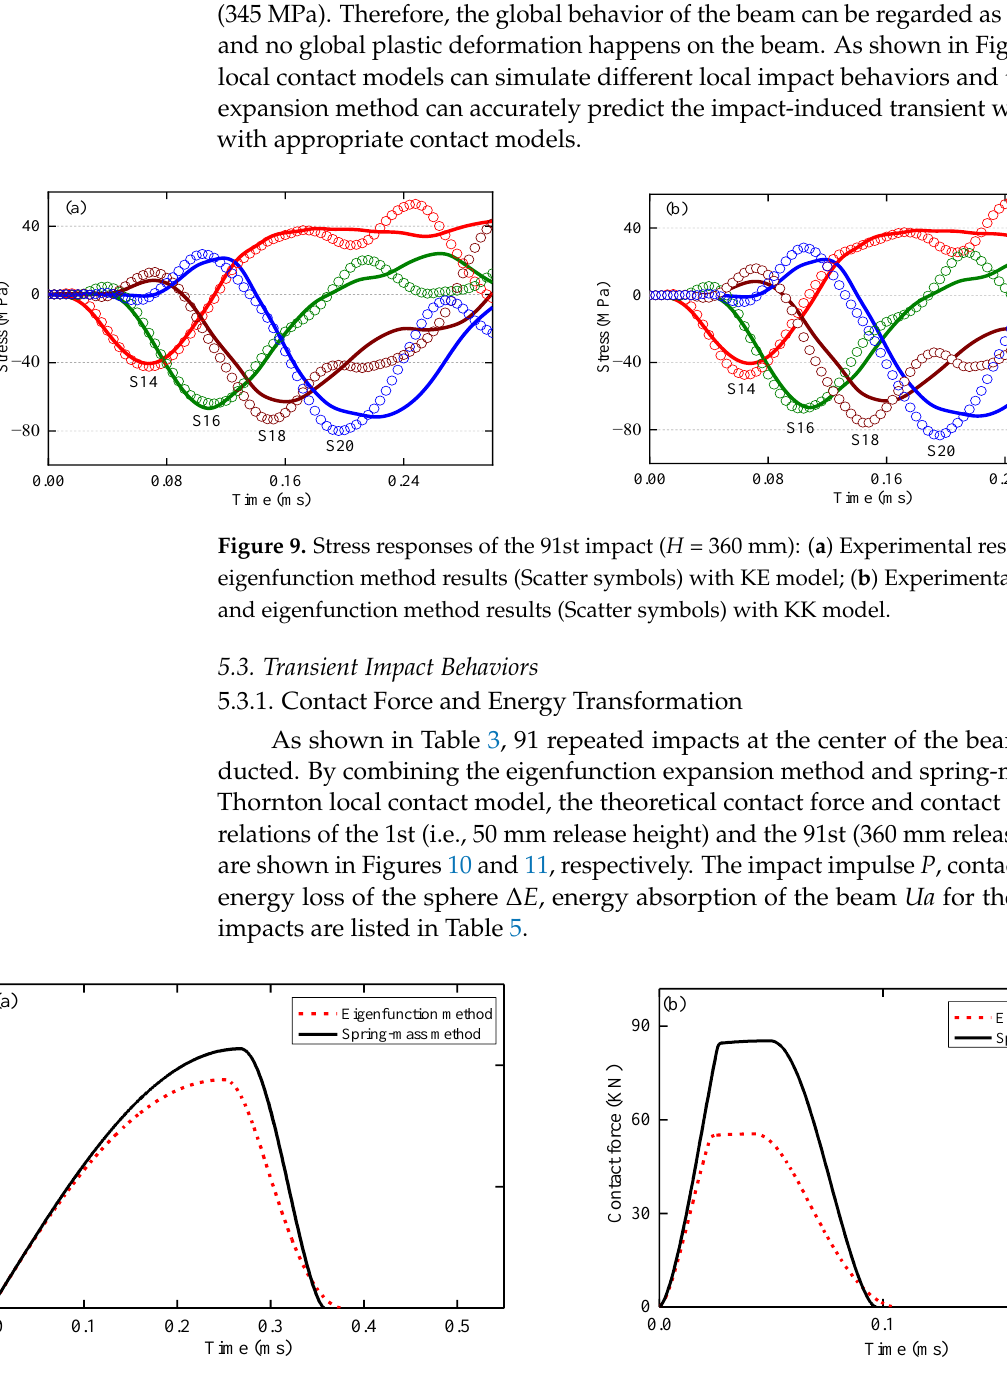
Figure 10. Contact force responses by eigenfunction expansion method and spring-mass method (with Thornton contact model): ( a ) the 1st impact, V 01 = 0.990 m/s; ( b ) the 91st impact, V 091 = 2.656 m/s.